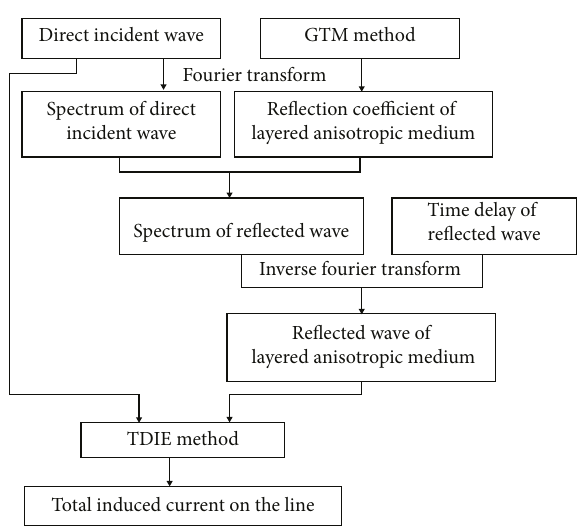
Figure 2: The fl ow diagram of the proposed